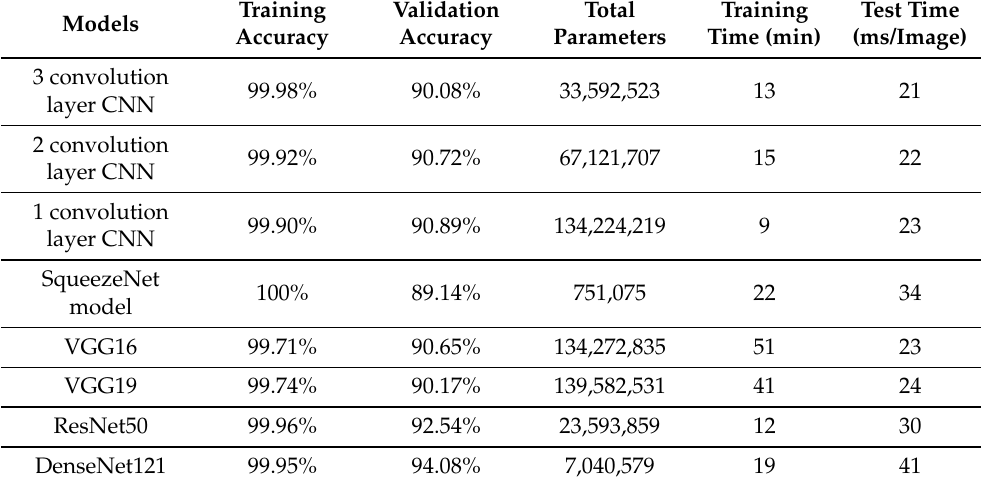
Table 2. Database with ambient light.